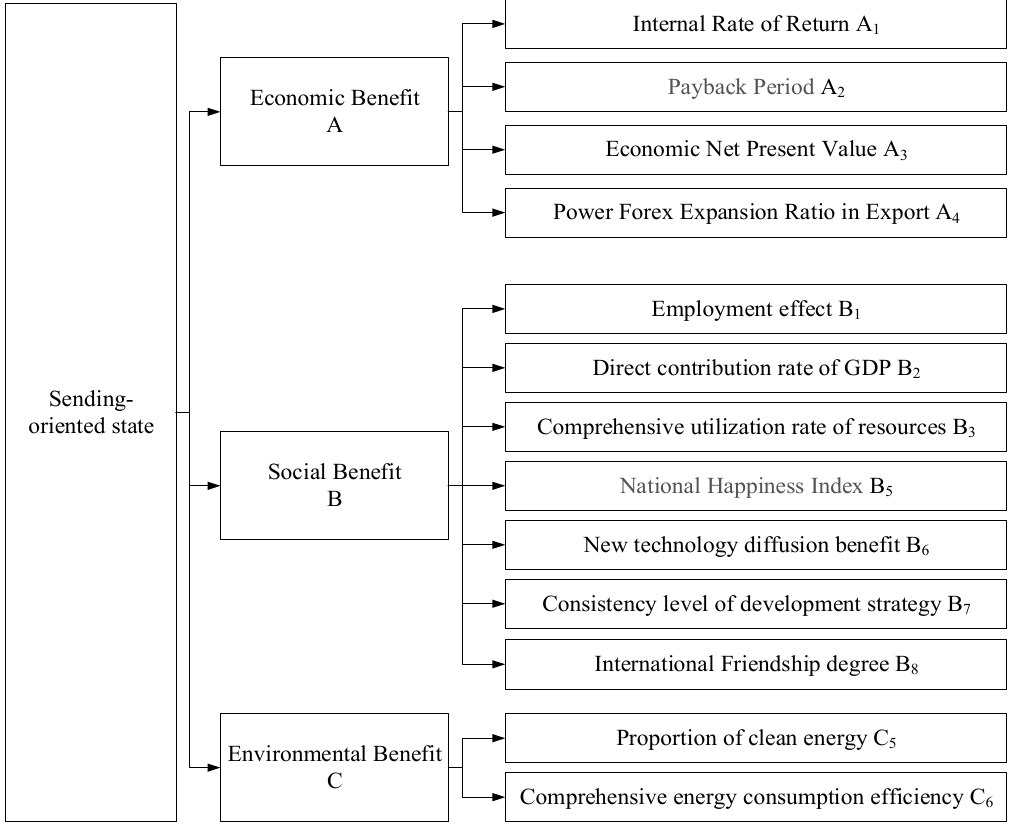
Figure 4. The comprehensive benefits evaluation index system of transnational power networking projects based on the perspective of sending-oriented states.